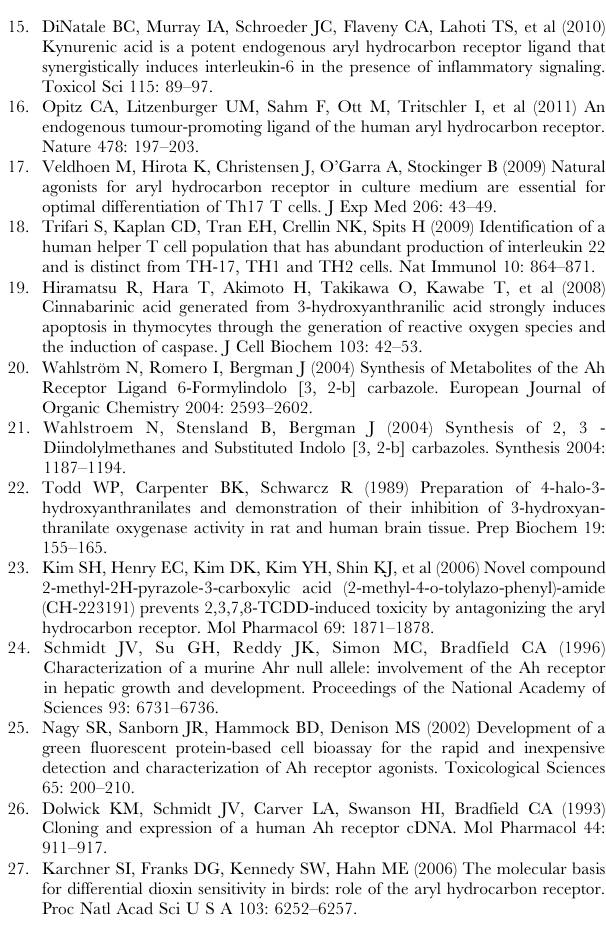
Figure S5 Effects of CA on cytokine production from mouse CD4 + T cells in total naı¨ve cell cultures. Flow cytometric analysis of the frequency of IL22 + (left) and IL17 + (right) CD4 + T cells relative to total events from sorted naı¨ve mouse CD4 + T cells from C57BL/6 mice stimulated under polarizing conditions (with IL-1 b , IL-6, TGF- b , anti-IFN c , and anti-IL12/23) in the presence of CA (25 or 35 m M) or DMSO (DMSO controls for the 25 and 35 m M CA experiments are shown separately). Data from six independent experiments were analyzed by one-way ANOVA and Bonferroni’s multiple comparisons test. Figure S6 Effects of CA on mouse Treg differentiation in total naı¨ve cell cultures. Flow cytometric analysis of frequency of FOXP3 + CD25 + CD4 + T cells relative to total events from sorted naı¨ve wild-type mouse CD4 + T cells stimulated with increasing concentrations of TGF b in the presence of DMSO or CA (10 or 25 m M). Quantification of %FOXP3 + CD25 + T cells of CD4 + cells from four independent experiments is shown. Error bars are SD.